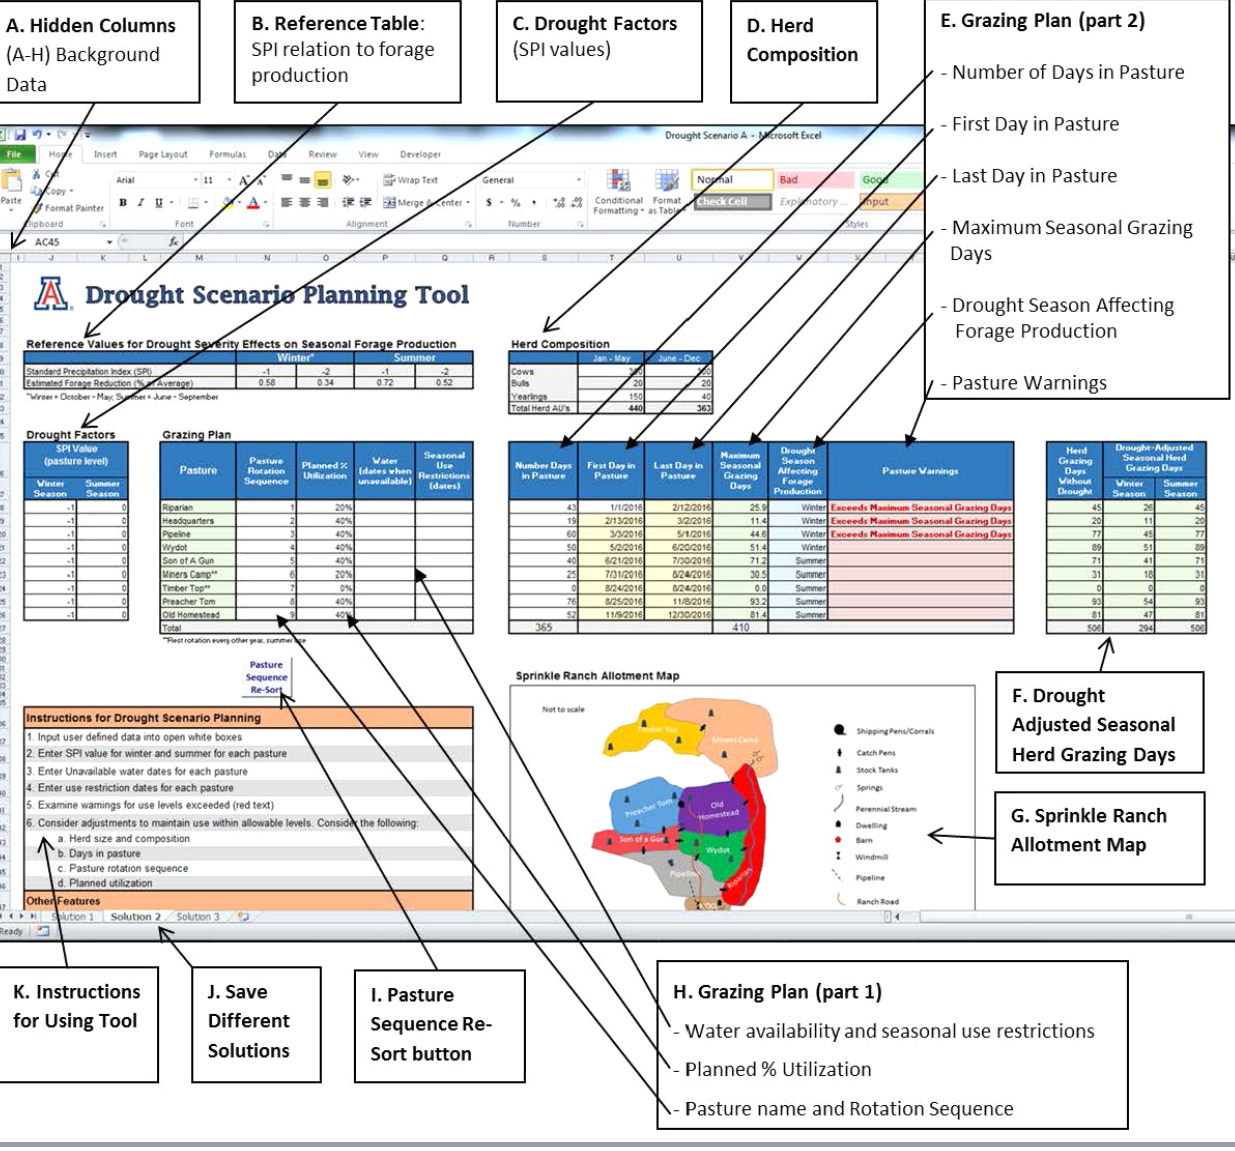
Fig. 3 . Drought scenario planning tool and labeled components. Note: SPI = Standard Precipitation